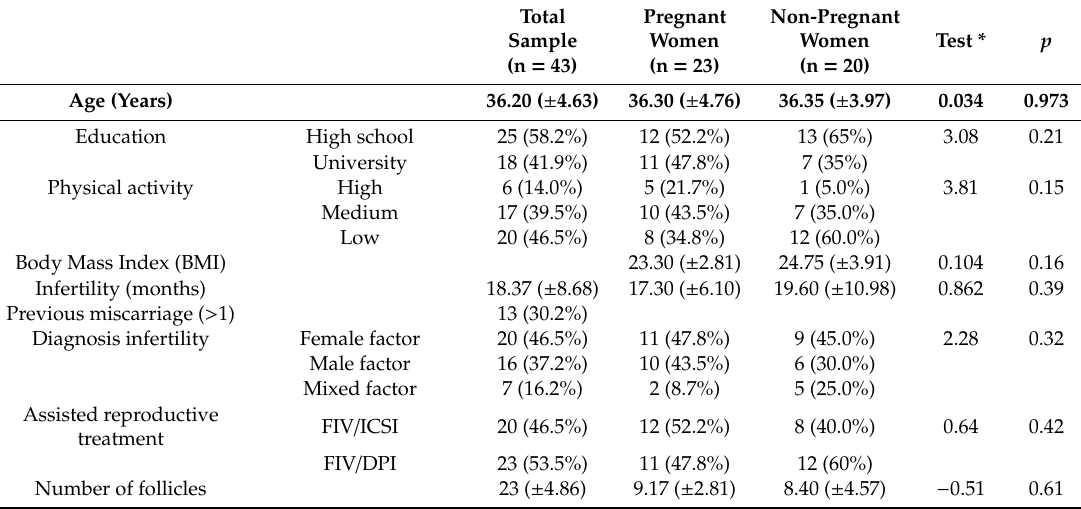
Table 1. Sociodemographic and clinical variables.